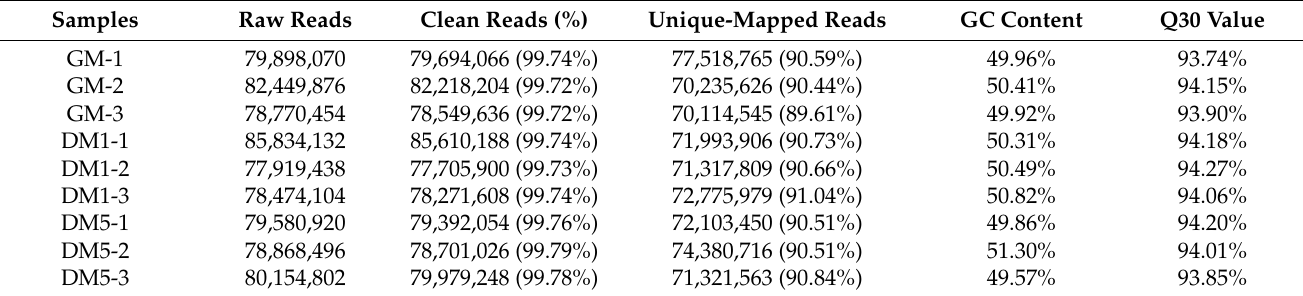
Table 2. Summary of the RNA-Seq data in